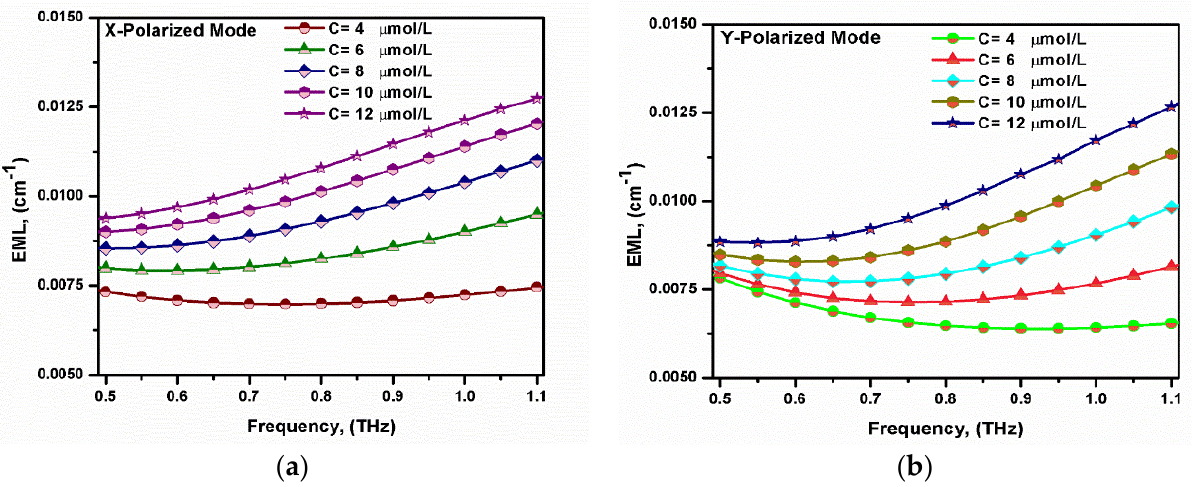
Figure 5. The variation of the EML with the frequency for the fundamental ( a ) x-polarized mode and ( b ) y-polarized mode at different bilirubin concentrations.